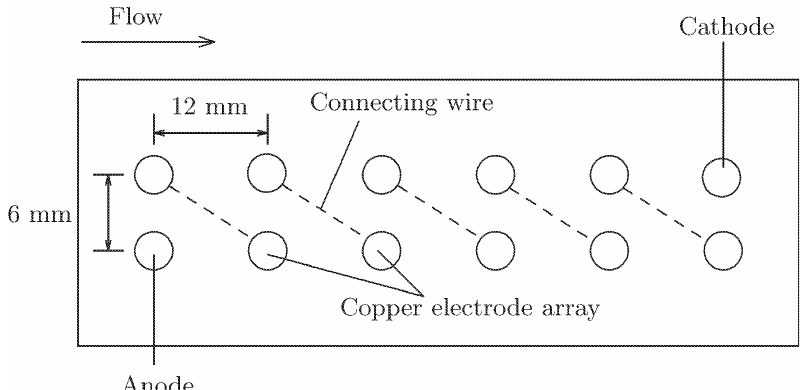
Figure 53. Surface Arc Plasma Actuator.